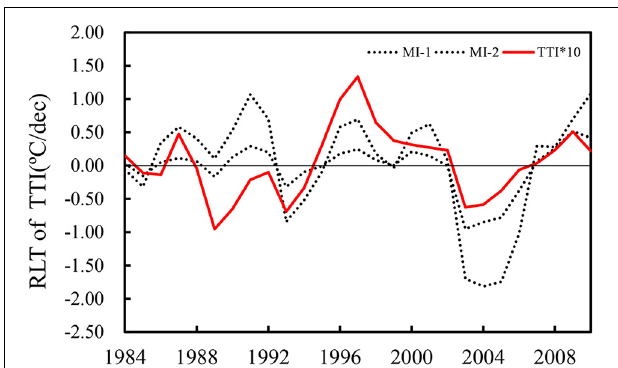
FIGURE 6 | The RLTs of the (TTI, ◦ C/dec) and SAMIs (MI1-1, MI-2) based on